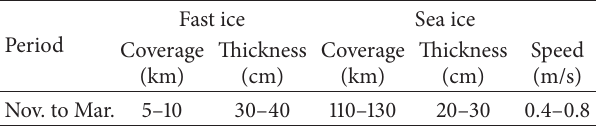
Table 5: The basic data of ice condition in the Bohai